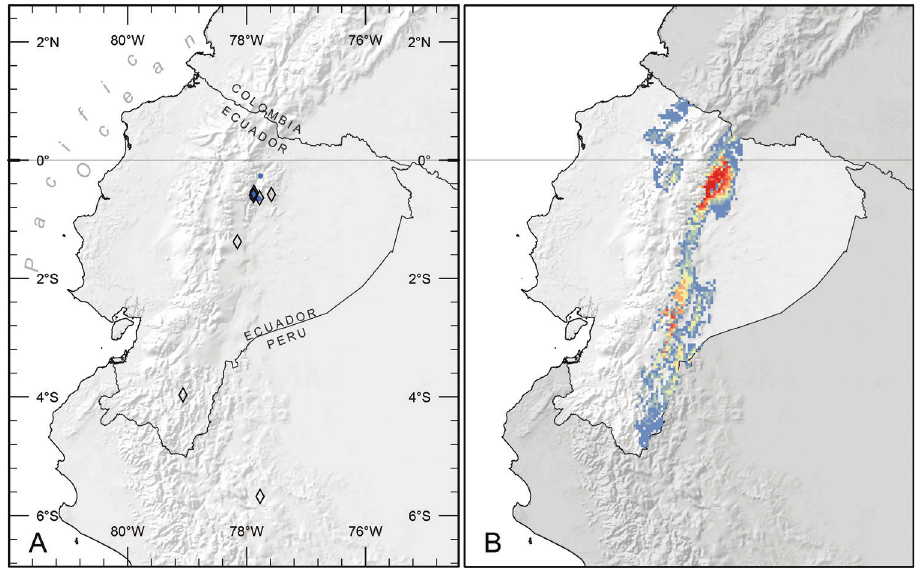
Figure 3. Distribution of Piper kelleyi . A Distribution of known localities based on collections (open diamonds) and study plots used to gather natural history data (blue circles) B Predicted distribution based on analysis of habitat parameters using the maximum entropy method. Areas in red are the most likely to have suitable habitat for P. kelleyi (probability = 0.75–0.87), and areas in blue (0.02–0.08) or unlabeled (< 0.02) are the least